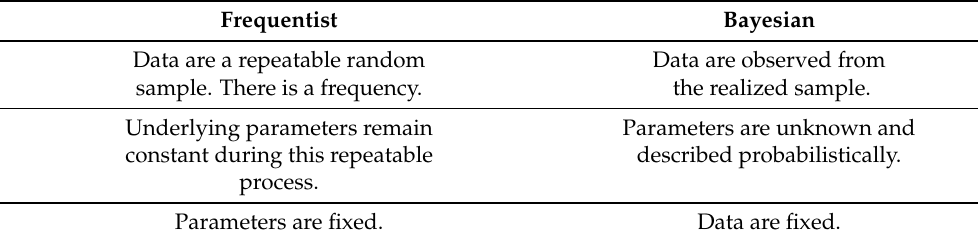
Table 1. Main differences between the Bayesian and Frequentist